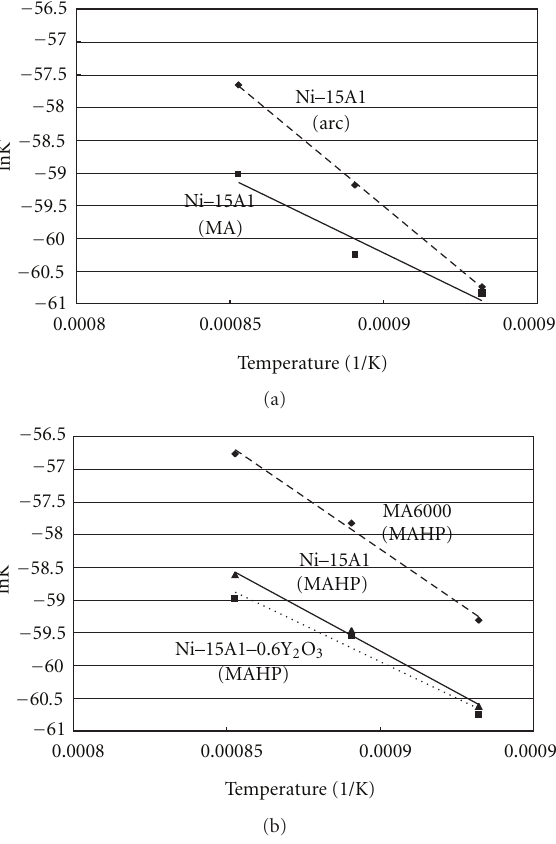
Figure 8: The Arrhenius plot for growth rate of γ (cid:2) precipitates.